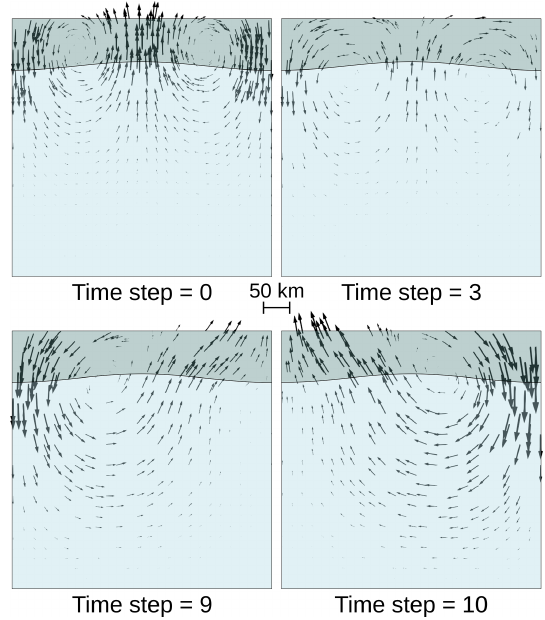
Figure E2. Simulation evolution for (cid:49)t = 5000 years, showing the sloshing instability: the velocity pattern changes from one time step to the other, with the velocity norm increasing each